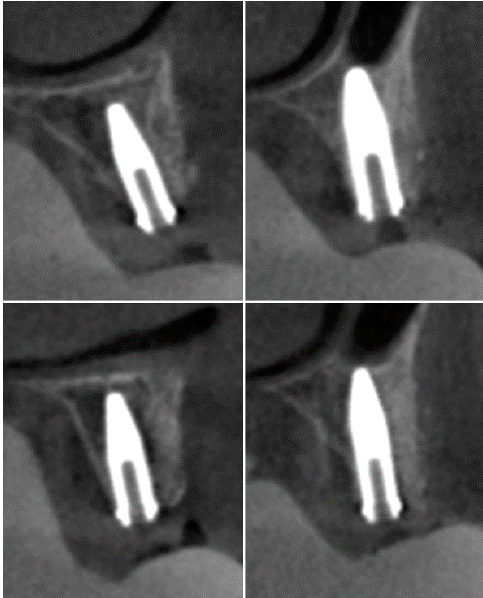
Figure 9. CBCT, performed at a 2-year follow-up, shows no signs of inflammation and bone resorption at the grafted sites and around implants.